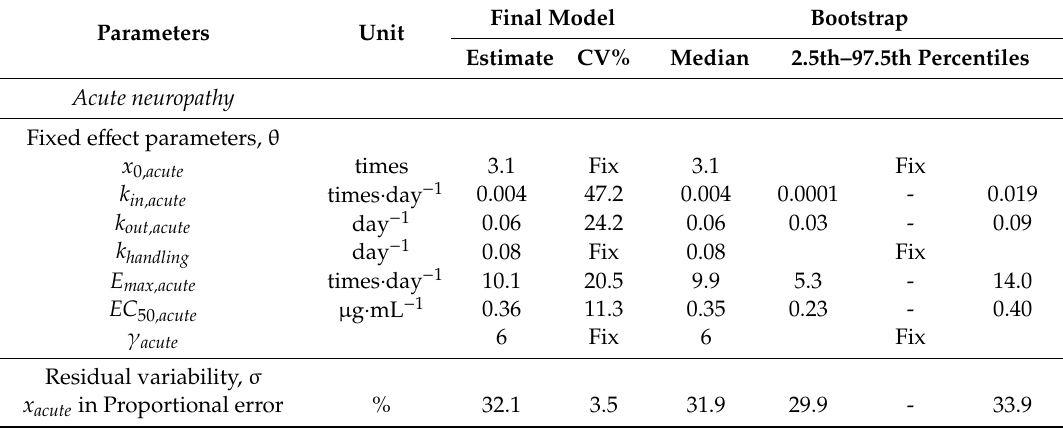
Table 2. PD parameters of acute and chronic neuropathy after administration of L-OHP in